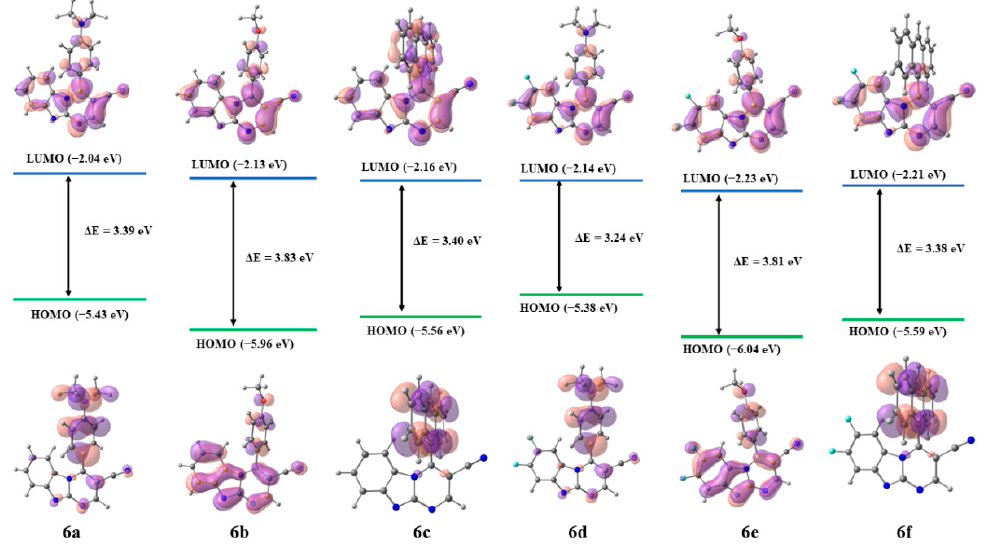
Figure 8. Energy gaps of fluorophores 6a–f in THF phase.